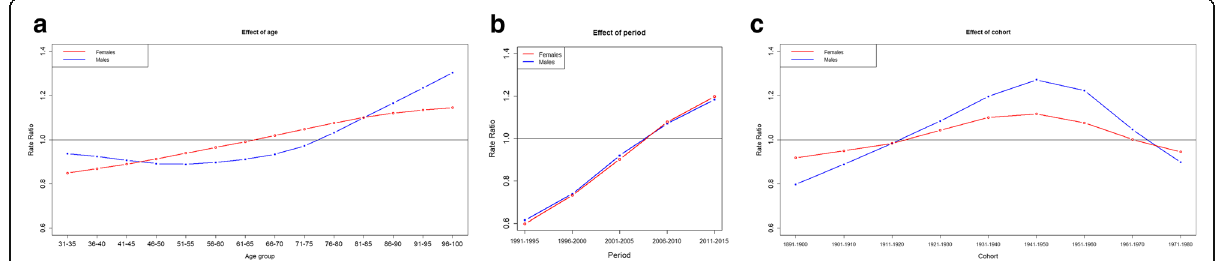
Fig. 3 Estimated effects of age, period and cohort in rate ratio terms by gender . a : estimated effect of age. b : estimated effect of period. c : estimated effect of cohort. Note. The dark central line indicates RR = 1